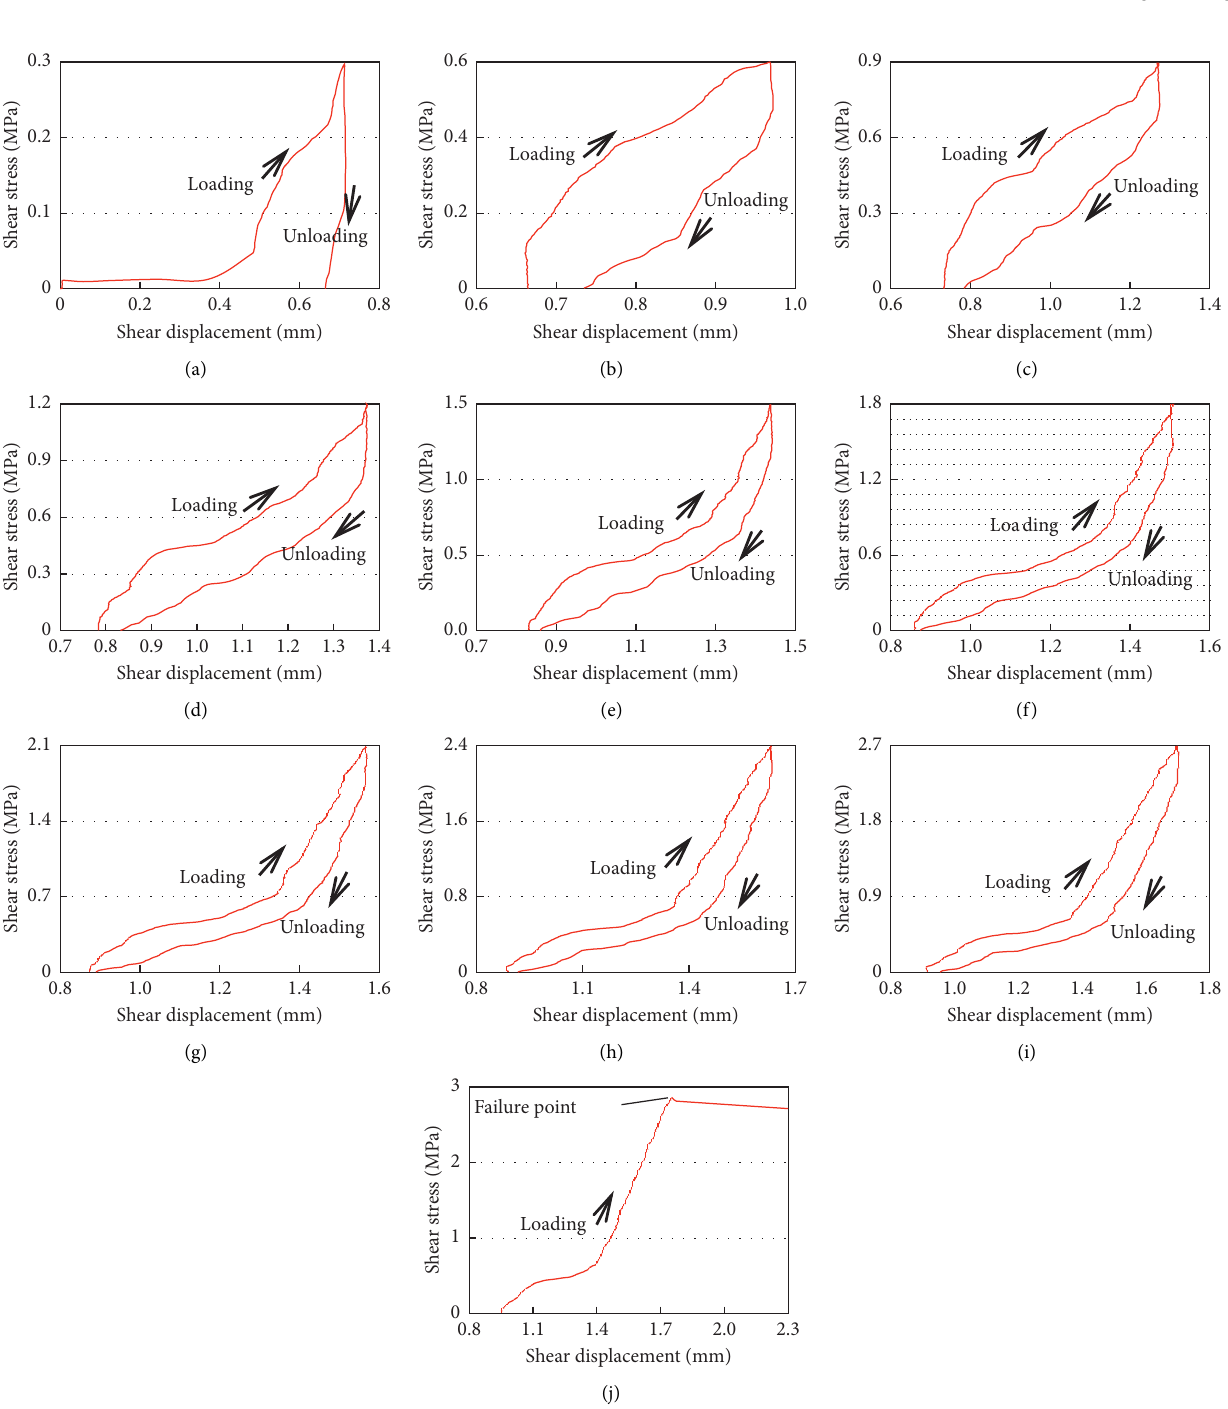
Figure 8: T - θ curves of TJ-1 at different cycles for (a)–(j):